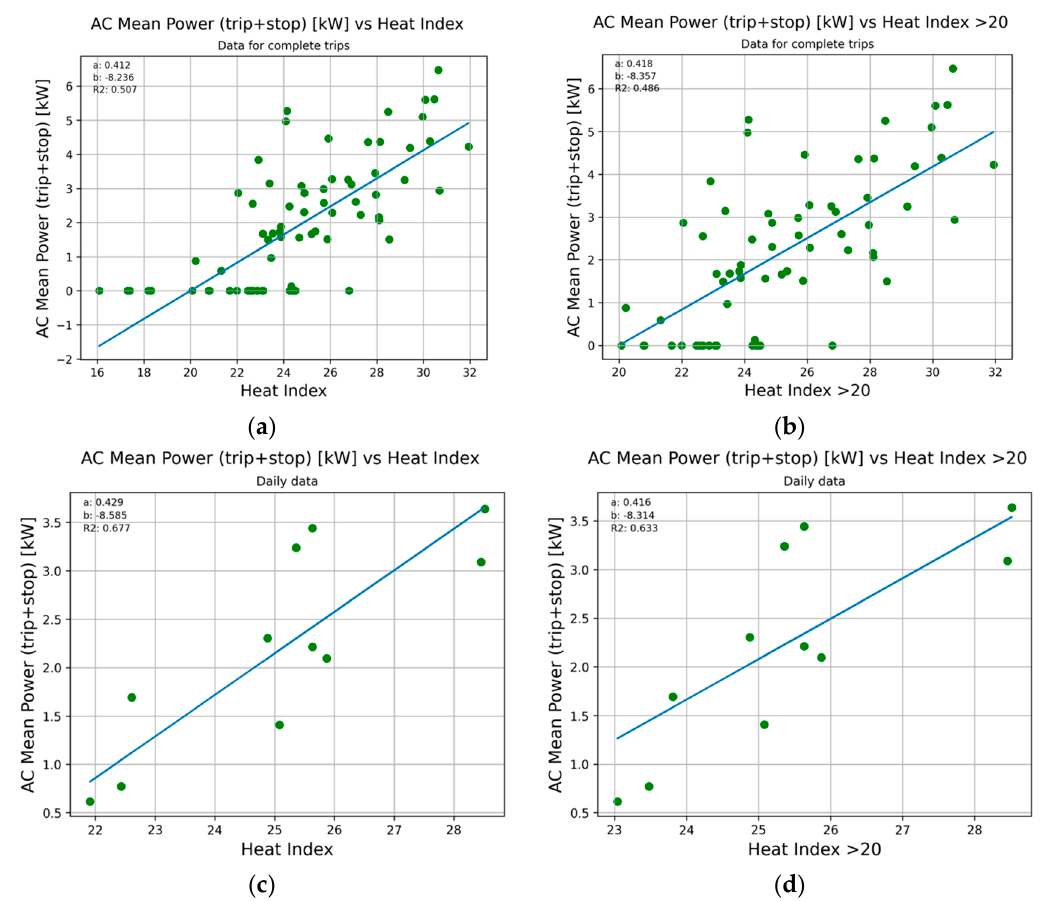
Figure 4. ( a , b ): scatterplot of the average power required by the air conditioning system in function of heat index, also considering the contribution at the bus stop. For Heat Index equal to 20 it is imposed that the Power is 0. ( a ): all data are included. ( b ): data couples characterized by heat index lower than 20 are removed. ( c , d ): same plots with daily average